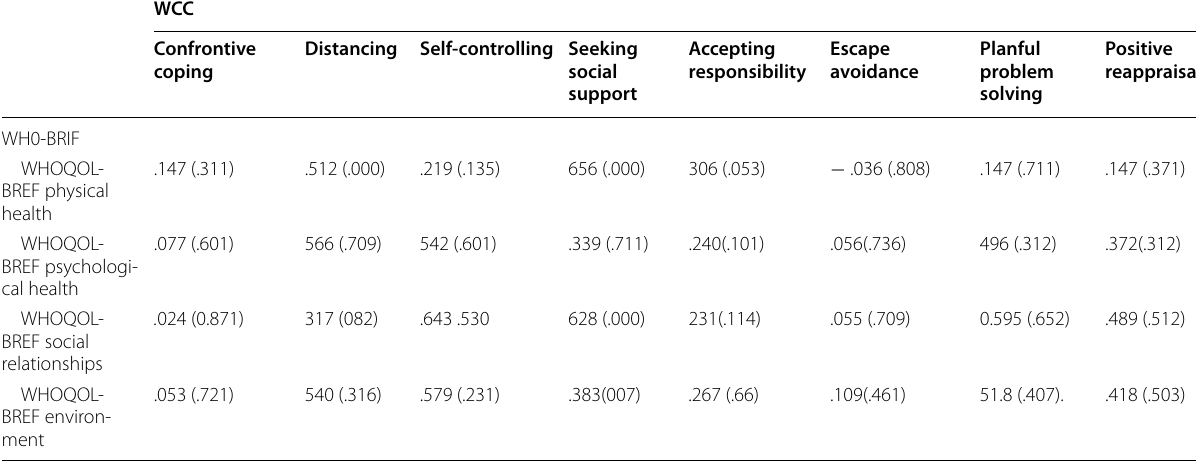
Table 2 Spearman correlation between Ways of Coping Checklist—Revised (WCC) and Quality of Life (WHOQOL-BREF) WCC Confrontive